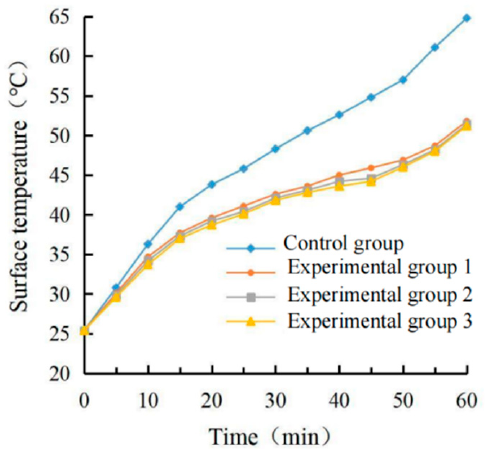
Figure 13. Surface temperature diagram.